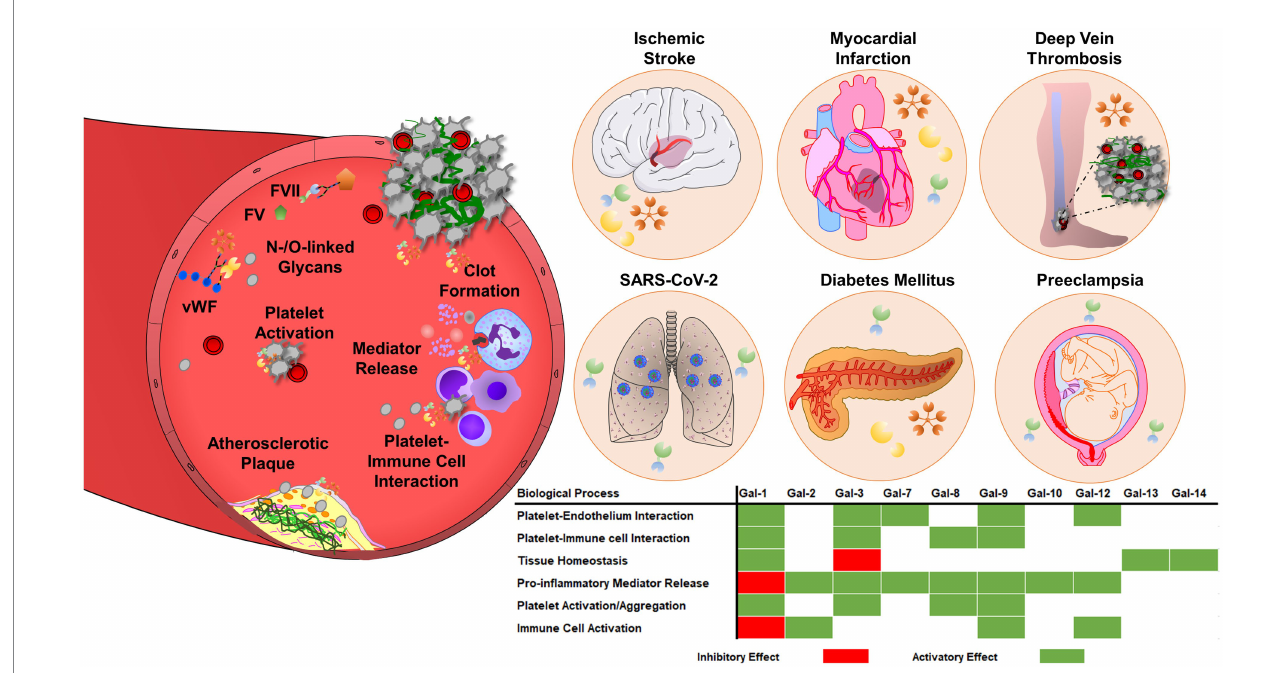
FIGURE 3 Galectins are involved in thrombosis and thromboinflammation through interplay with vascular endothelium, immune cells, and blood platelets. Galectins can promote platelet adhesion activation and regulate coagulation pathways, through interactions with glycoproteins, integrins, and coagulation factors. Galectins have multiple roles in thromboinflammatory diseases, such as atherosclerosis, myocardial infarction, deep vein thrombosis, or ischemic stroke. The regulatory role of galectins strongly depends on the pro-thrombotic, pro-inflammatory, and immunosuppressive landscape of the vasculature and surrounding environment. Therefore, the effects of galectins may vary depending on the stage and pathogenesis of the